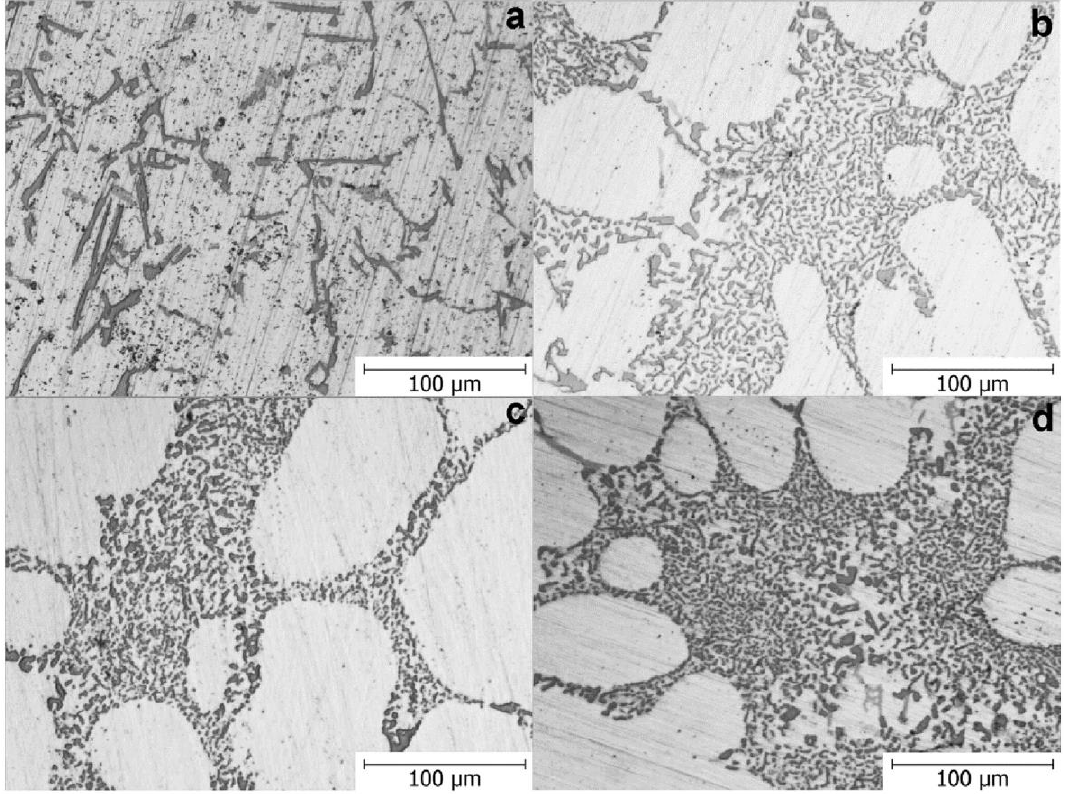
Figure 3. Microstructure images of A356 cast samples with different Sr addition ( a ) No Sr addition, ( b ) 120 ppm, ( c ) 170 ppm, and ( d ) 250 ppm. Reprinted with permission of [5].